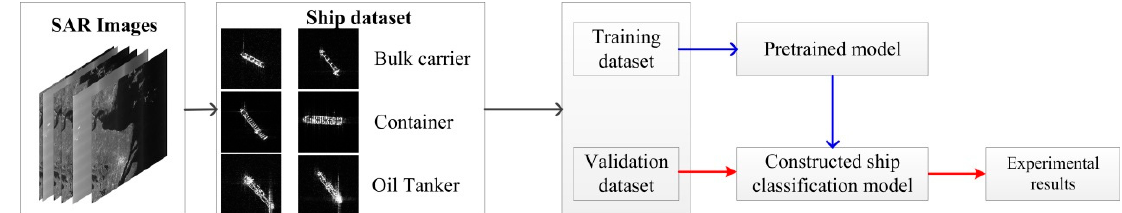
Figure 2. Experimental workflow. The black, blue, and red arrows represent the data processing, training, and test phases, respectively.